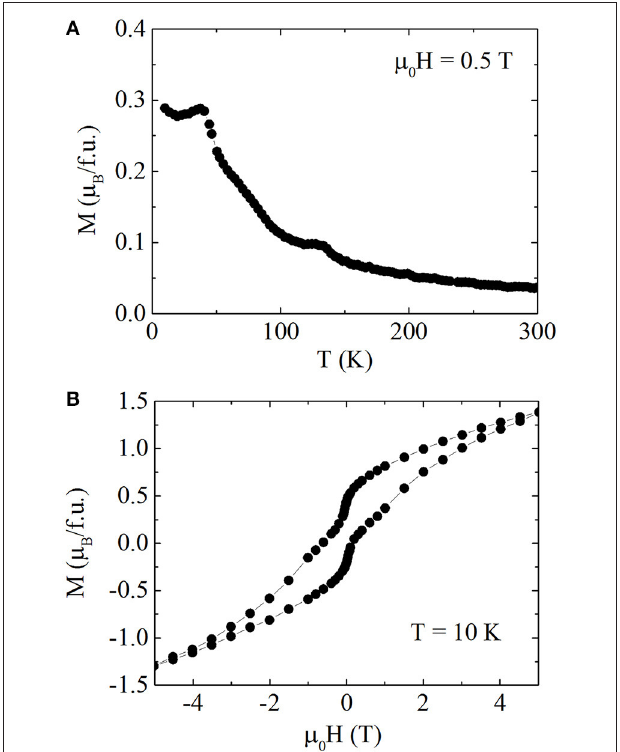
FIGURE 10 | Temperature dependence at 0.5T (A) and magnetic field dependence at 10K (B) of the in-plane magnetization of a LMO:Mn 3 O 4 nanocomposite.